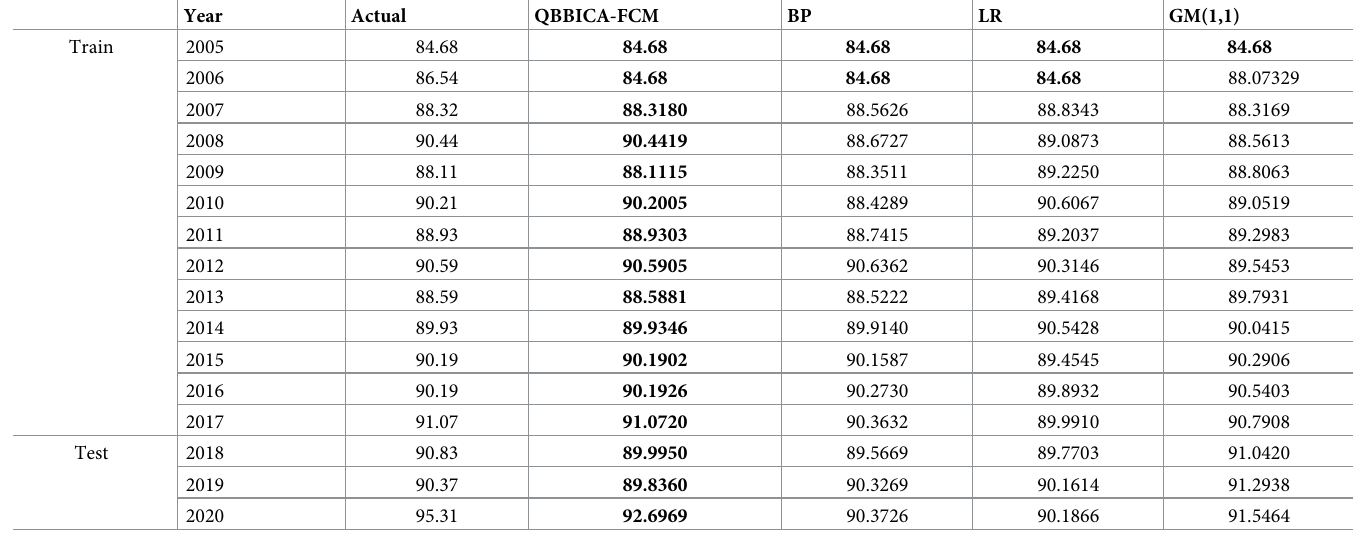
Table 10. Prediction results comparison of QBBICA-FCM between BP, LR and GM(1,1). Year